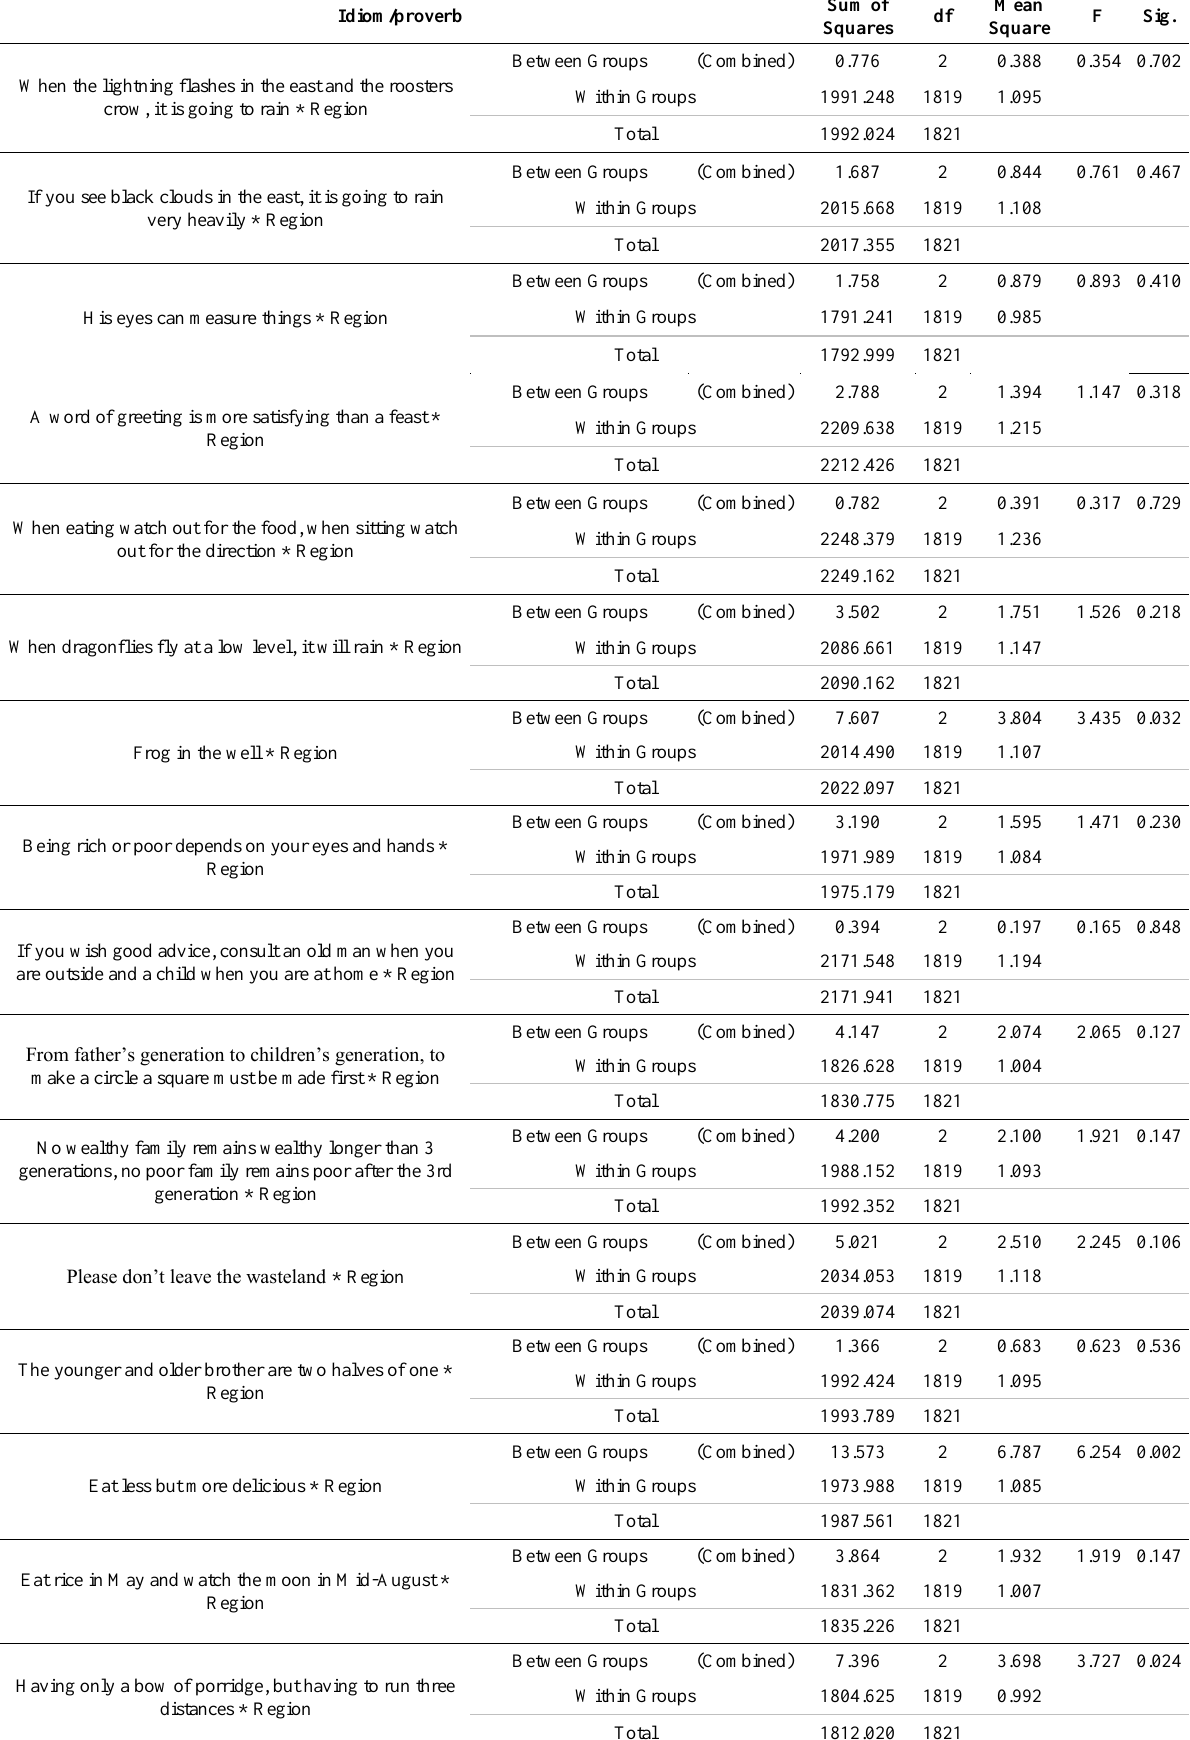
Table 3. Results of ANOVA test on mean scores among three regions (the North, the Central, the South)